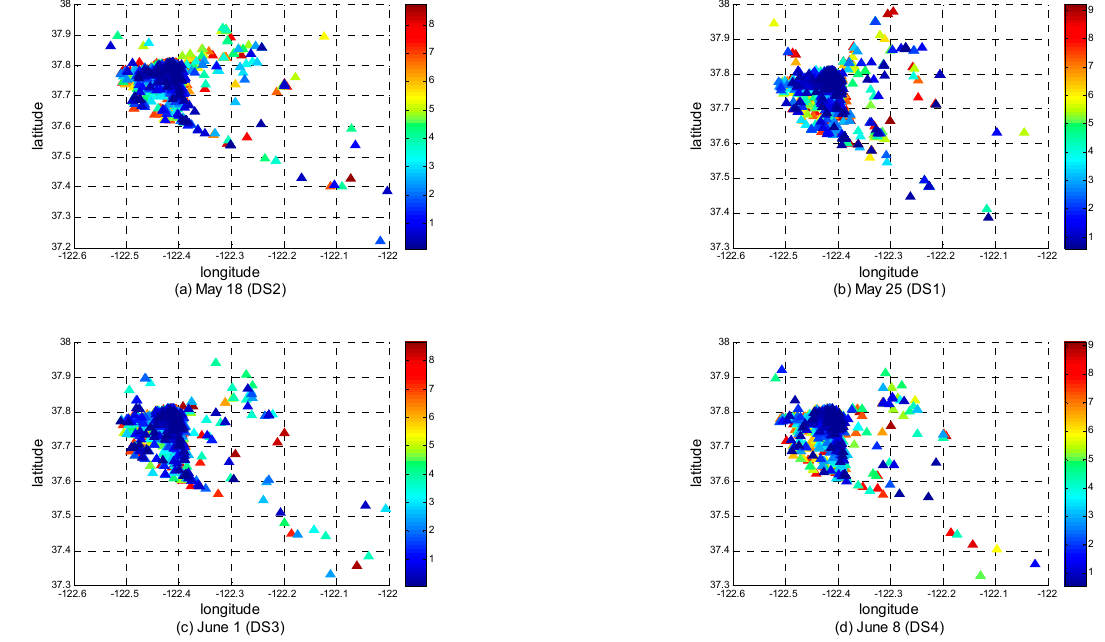
Figure 10. The time-sequential coloring graph of optimal stay centers. The k -means clustering method is used for datasets DS1 – DS4 .